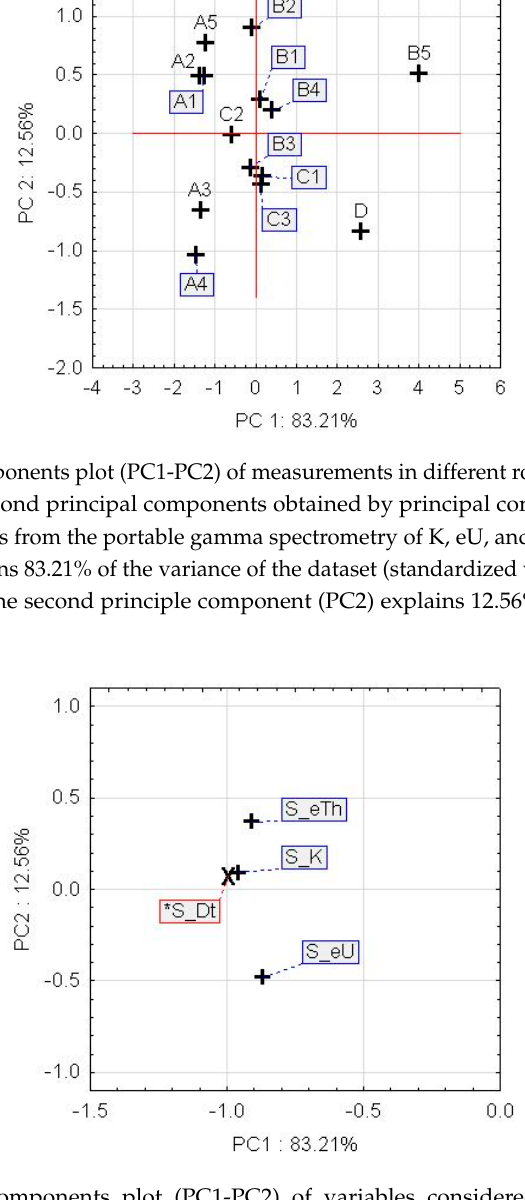
Figure 6. Principal components plot (PC1-PC2) of variables considered. S_K, S_eU, S_eTh, and S_ Dt refer to standardized values of variables. S_ Dt , standardized dose rate, is used as a supplemental variable not considered in the deduction of the principal components. The first principle component (PC1) explains 83.21% of the variance of the dataset (standardized values of K, eU, and eTh measurements), while the second principle component (PC2) explains 12.56% of the variance of the studied dataset.